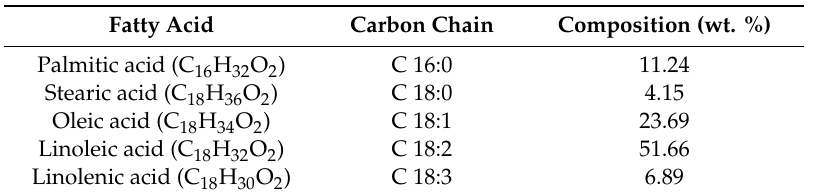
Table 1. FFA content of soybean oil [22].